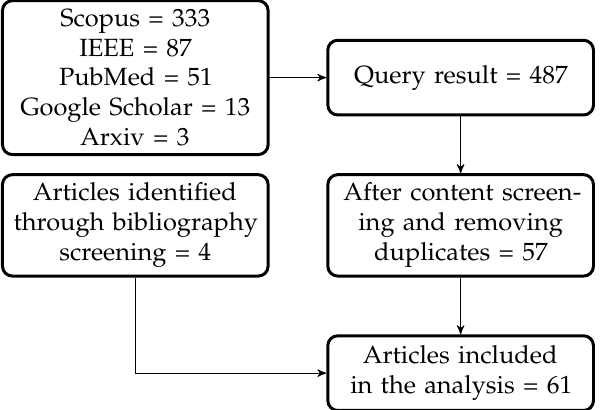
Figure 1. Databases query results and paper selection process.